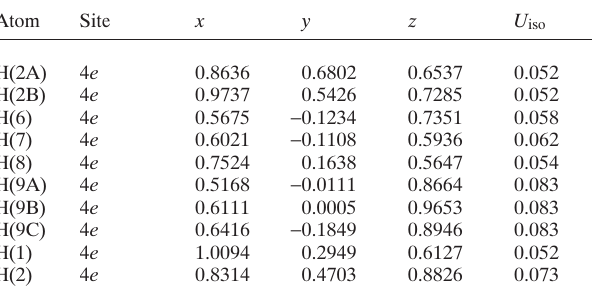
Table 2. Atomic coordinates and displacement parameters (in Å 2 )